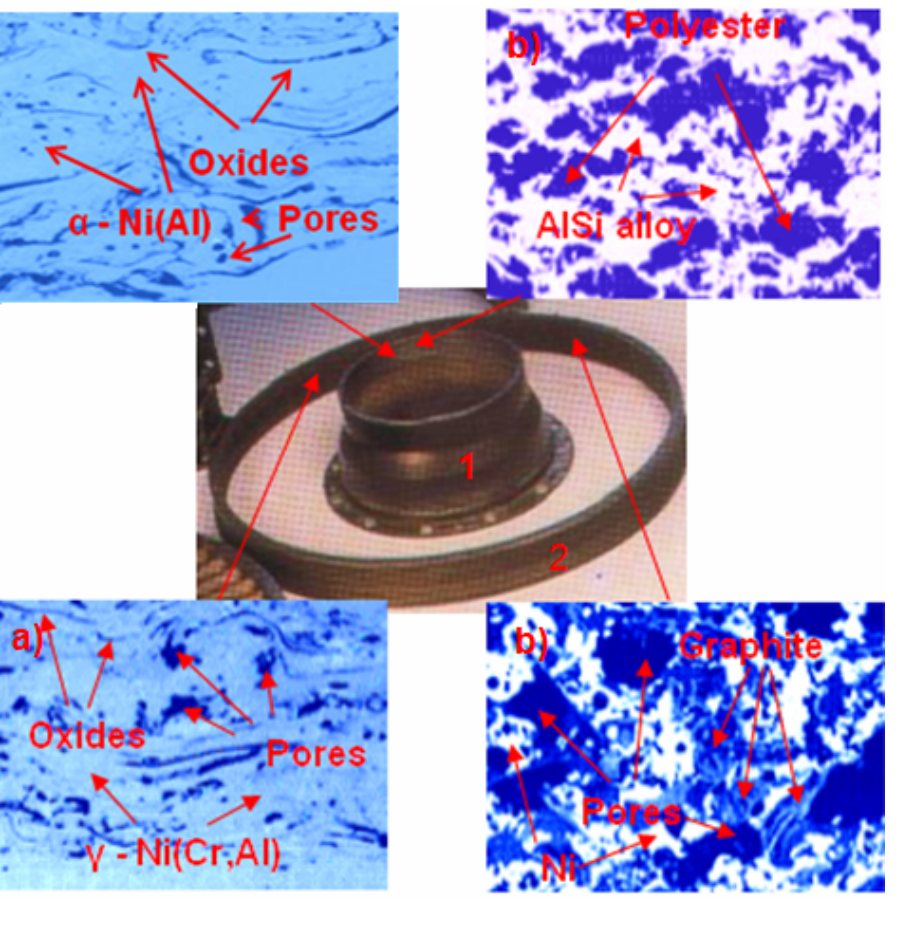
Figure 3 – Air labyrinth ring (1) with the microstructure of the NiAl / AlSi12 polyester coating system and the working ring of the compressor of the V – X degrees (2) with the microstructure of the NiCrAl / Ni-25% graphite coating system Slika 3 – Prsten vazdušnog labirinta (1) sa mikrostrukturama sistema prevlaka NiAl / AlSi12 poliester i radni prsten kompresora od V - X stepena (2) sa mikrostrukturama sistema prevlaka NiCrAl /